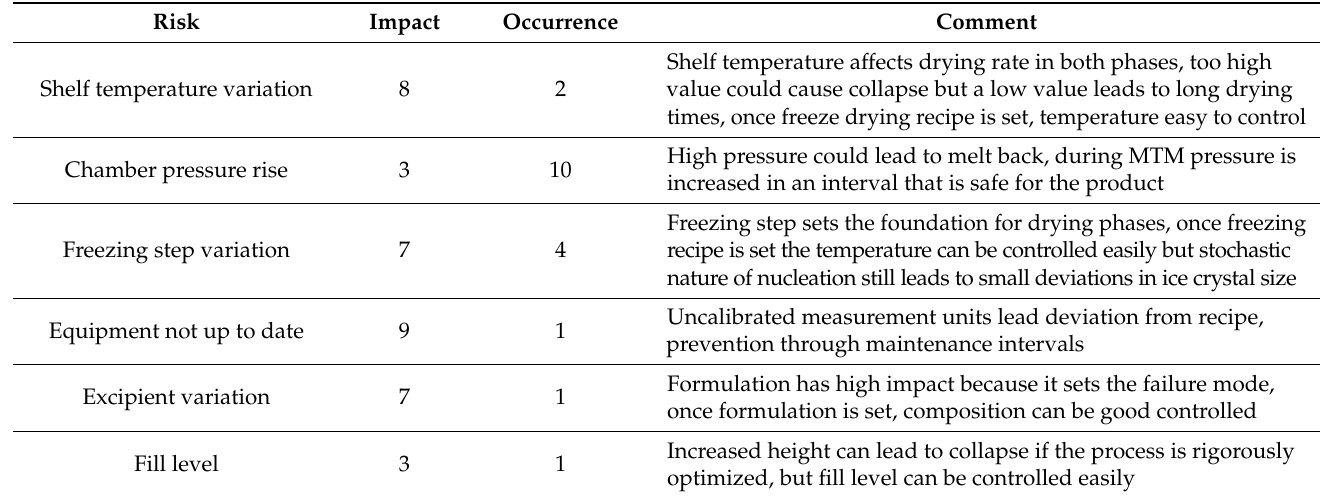
Table 1. QbD risk assessment: FMEA.